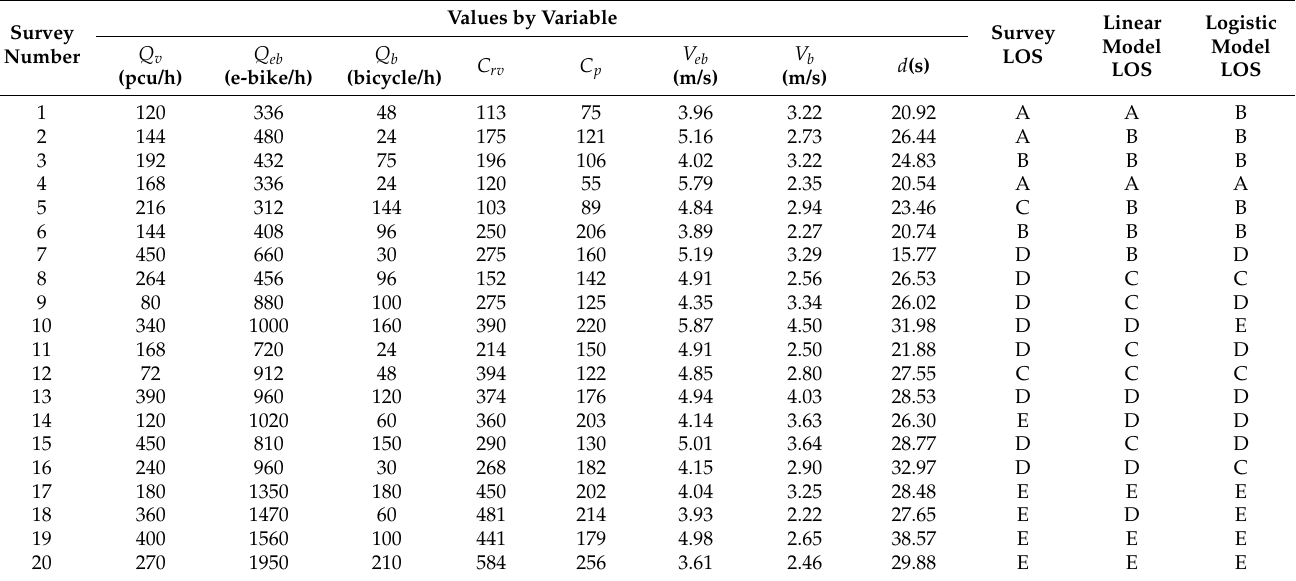
Table 8. Evaluation of Proposed LOS Model of The Non-motorized